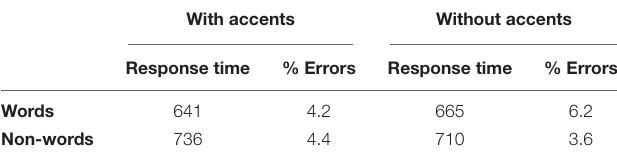
TABLE 1 | Mean lexical decision times (in ms) and error rates (in percentages) for words and non-words with vs. without accent marks in Experiment